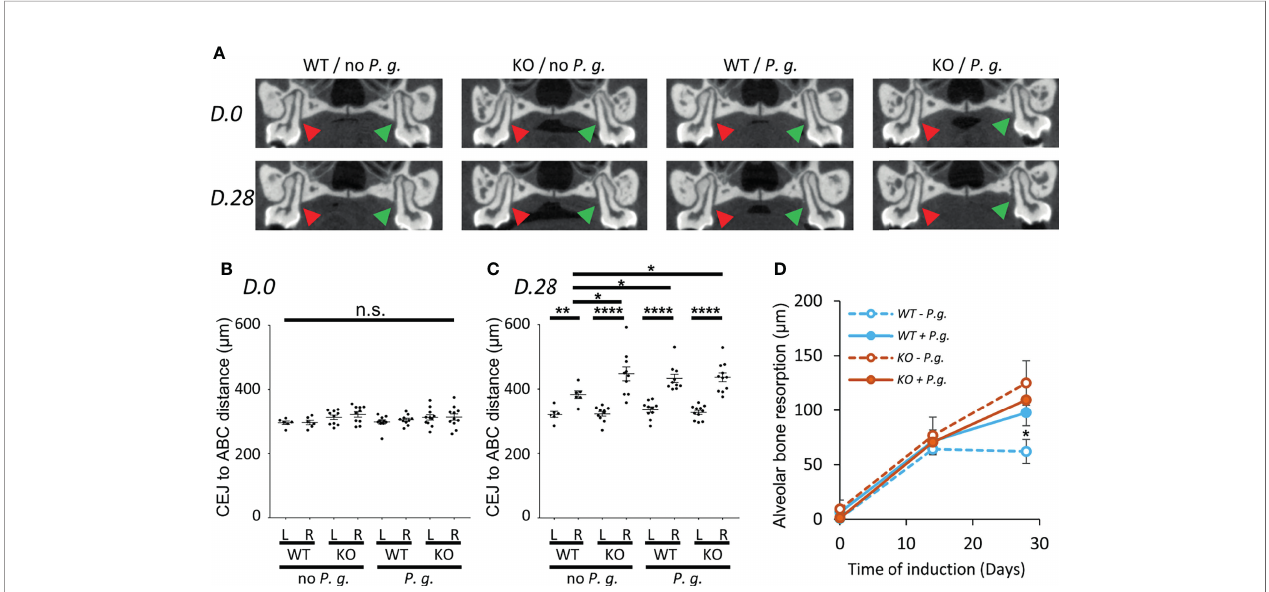
FIGURE 1 | Alveolar bone resorption measurement on Micro-CT images. WT or NLRP3 KO mice were subjected to periodontitis induction with the insertion of a silk ligature with ( P. g. ) or without P. gingivalis (no P. g.) on the palatal side of the fi rst right molar as described in the material and method section. Micro-CT analysis was performed before (D. 0), during (D. 14), and at the end of the experiment (D. 28). (A) The distance between Cement-Enamel Junction (CEJ) and Alveolar Bone Crest (ABC) was measured on 3 consecutive sections (100 µm) of the fi rst palatine molars centered around the section shown in A, both on the left non-treated side (red arrowhead, L) and the right treated side (green arrowhead, R). (B, C) Mean of CEJ to ABC distances are shown, each dot represent the mean obtained from a single mouse. Measurement of D. 0 (B) and D. 28 (C) are shown, horizontal bars represent the mean +/- SEM. (D) Time course plots representing the mean +/- SEM of the difference between right (R) and left (L) side of the CEJ to ABC distance shown in (B, C) . Blue lines represent WT mice, orange lines represent NLRP3 KO mice, solid line are mice treated with P. gingivalis , dashed lines are mice treated without P. gingivalis . Uncorrected Dunn ’ s test. *P < 0.05, **P < 0.01, ****P < 0.0001, n.s. P ≥ 0.05, non-signi fi